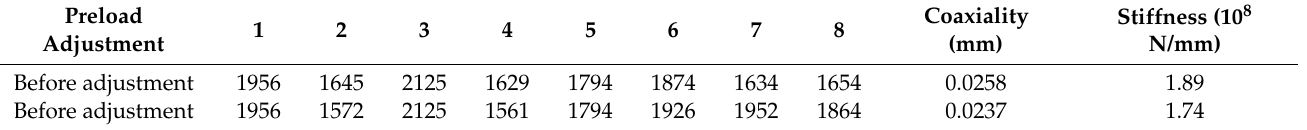
Table 8. Bolt preload comparison (unit: N).